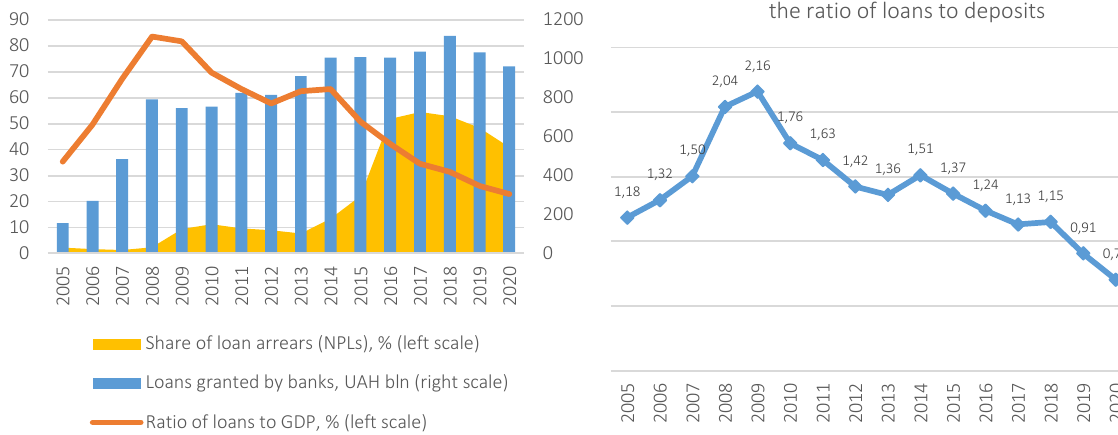
Figure 6. Indicators of Ukrainian banks’ lending activity in